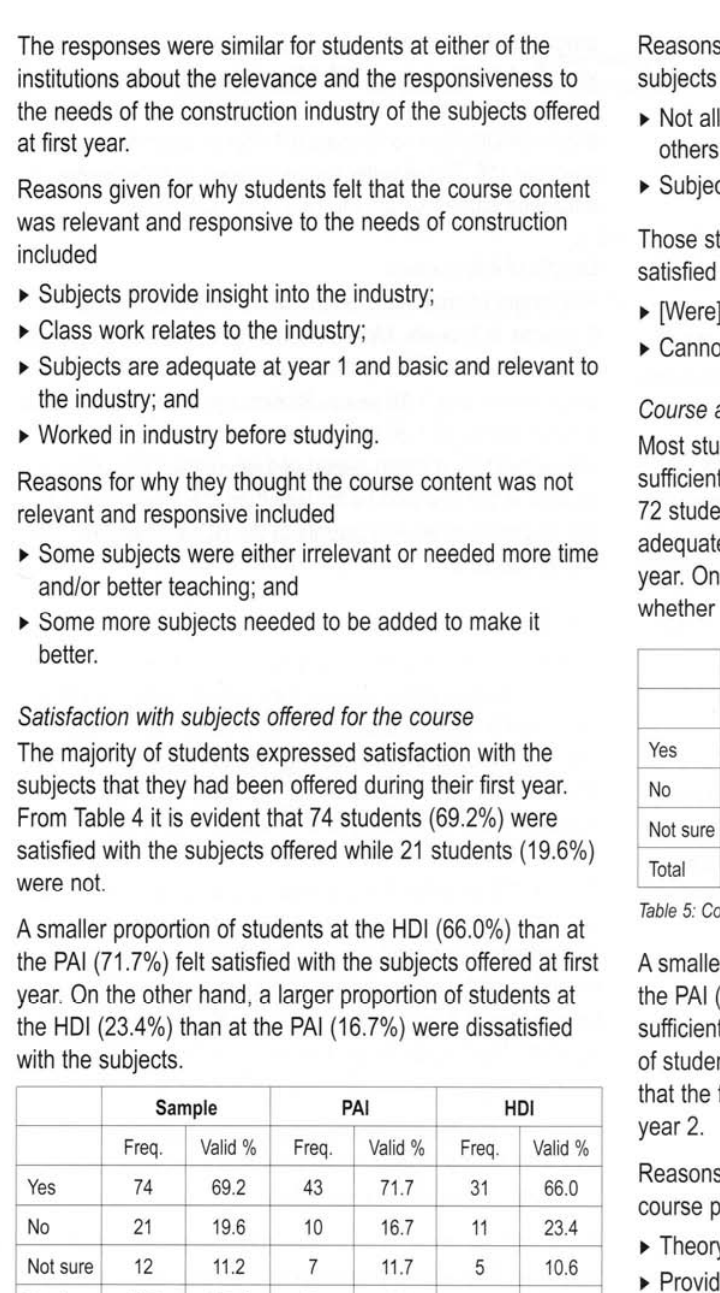
Table 4: Satisfaction with subjects offered during first year Reasons given for why students were satisfied with the subjects offered during first year included